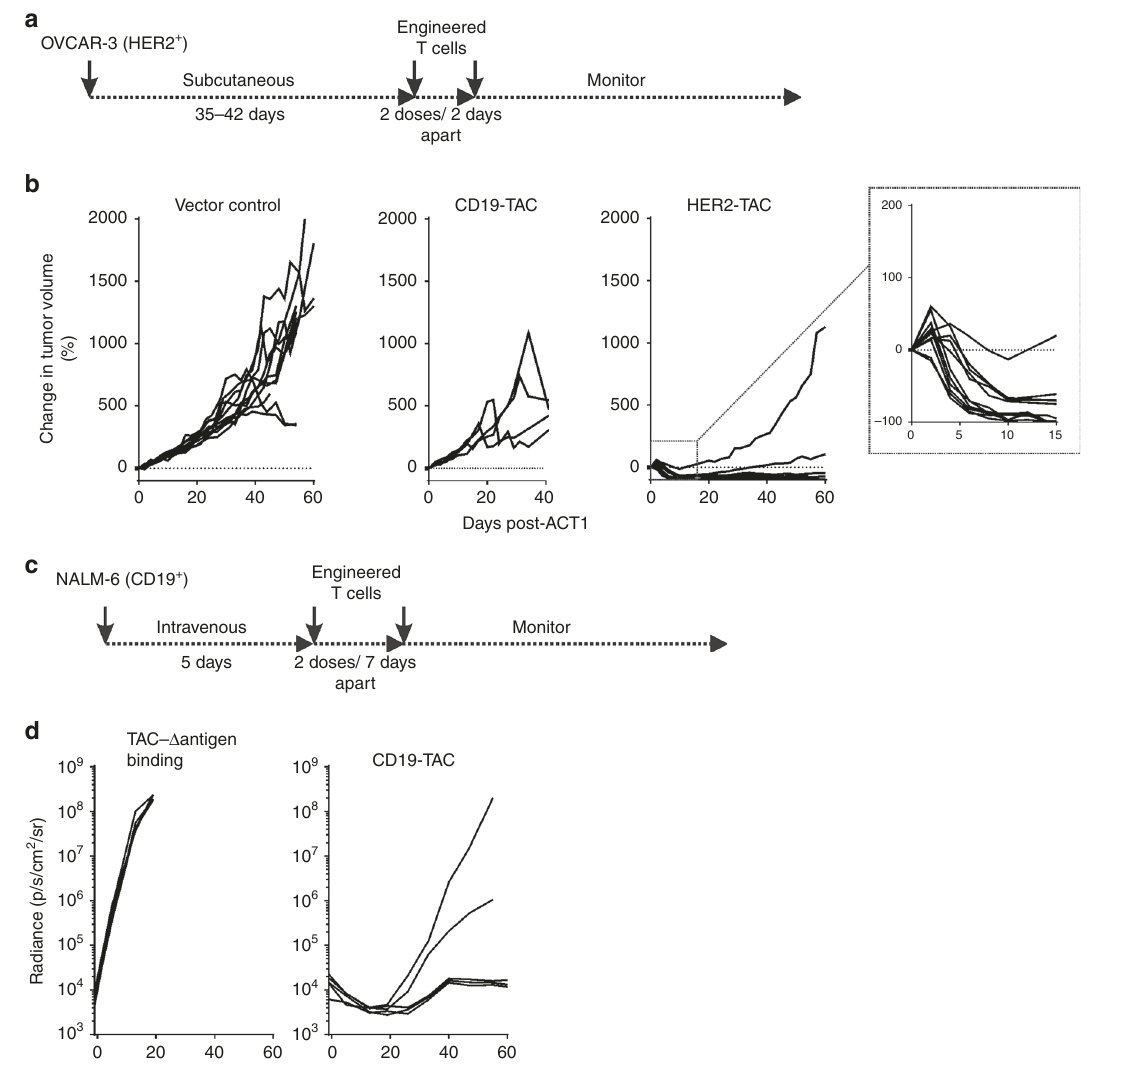
Fig. 4 TAC-T cells demonstrate in vivo ef fi cacy against solid and liquid tumors. a Treatment schema for OVCAR-3 tumor-bearing mice. In short, NRG mice receive 2.5 × 10 6 OVCAR-3 cells subcutaneously. Tumors grow for 35 – 42 days until an average size of ~100 mm 3 is achieved. T cells are delivered over